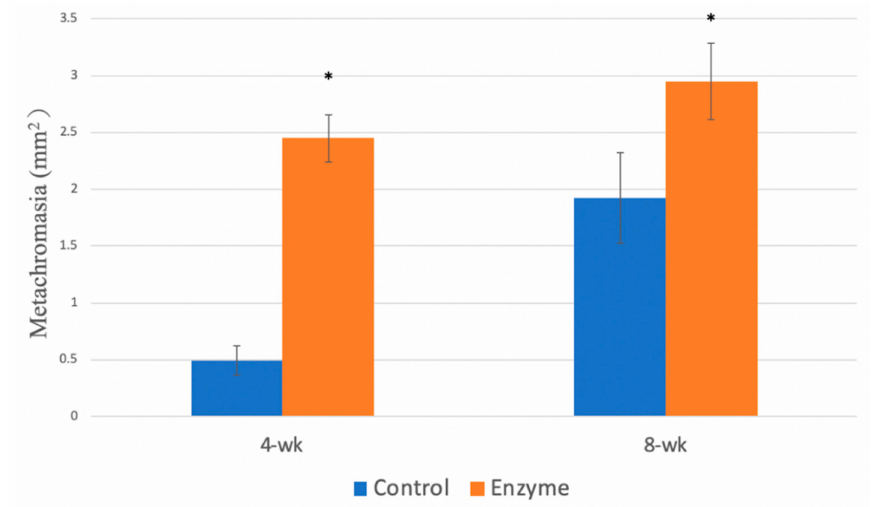
Figure 7. Metachromacia. The area of metachromcia was significantly increased in both 4-week and 8-week groups after collagenase treatment ( p < 0.01). The error bars designed the standard